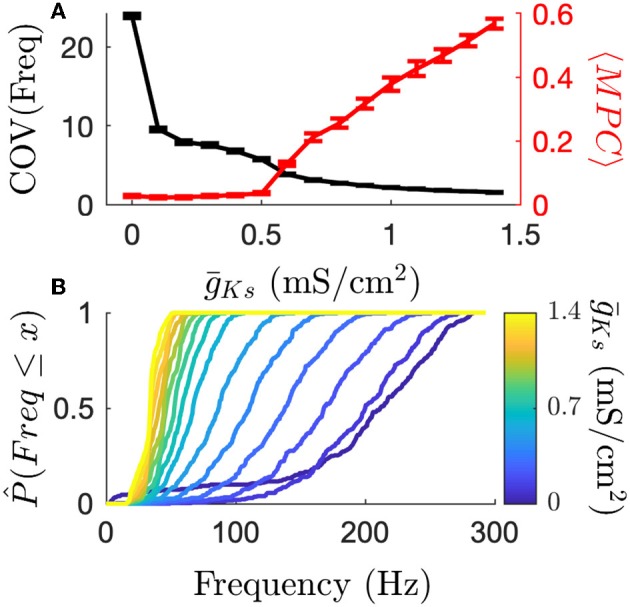
The transition from high frequency variance to high phase locking shows how cholinergic modulation can change coding principles. (A) High ACh networks have highly varied firing rates as measured by the coefficient of variation. Firing rates quickly become more uniform as g¯Ks increases. Conversely, MPC (phase locking) is high for low ACh networks. (B) Frequency CDFs for single simulations, each on the same network structure, show that the same network display large differences in the variance of firing rates across the network. High ACh networks have high variance, which deceases dramatically as ACh is reduced. Error bars indicate s.e.m.